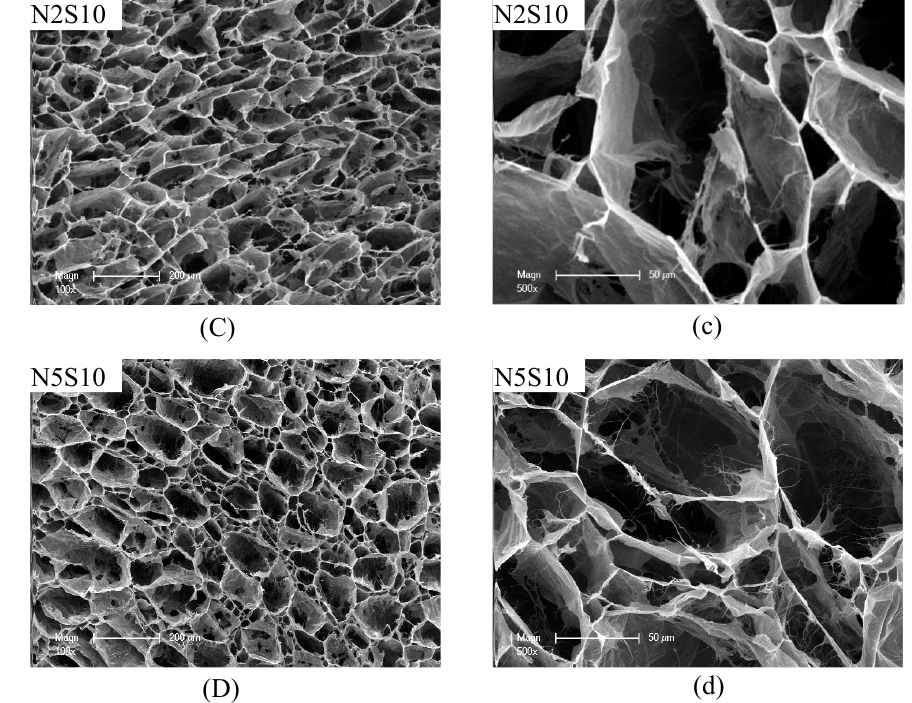
Figure 8. N2S5 ( A ): 2 wt% NaOH and 5 min sonication, N5S5( B ): 5 wt% NaOH and 5 min sonication, N2S10( C ): 2 wt% NaOH and 10 min sonication, N5S10( D ): 5 wt% NaOH and 10 min sonication (( a )( b )( c )( d ) for its corresponding enlargered version).